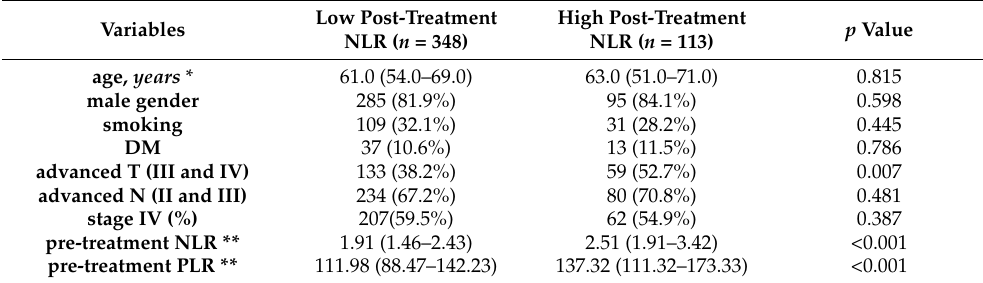
Table 2. Clinicopathological characteristics according to the post-treatment